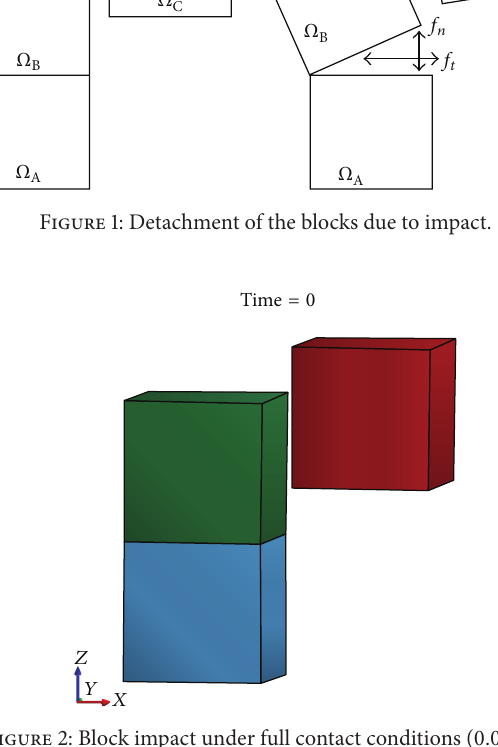
Figure 2: Block impact under full contact conditions (0.0 sec).